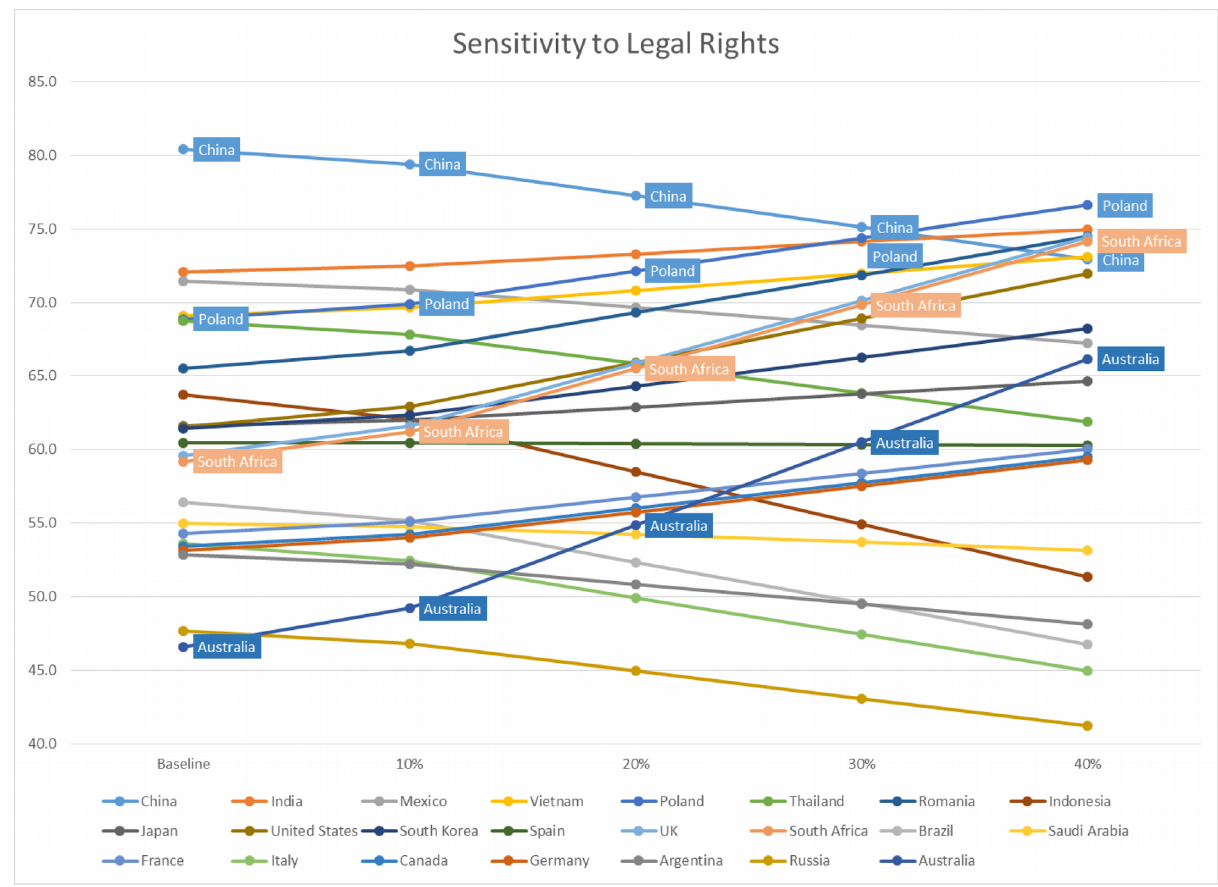
Figure 6. Legal rights utility weight